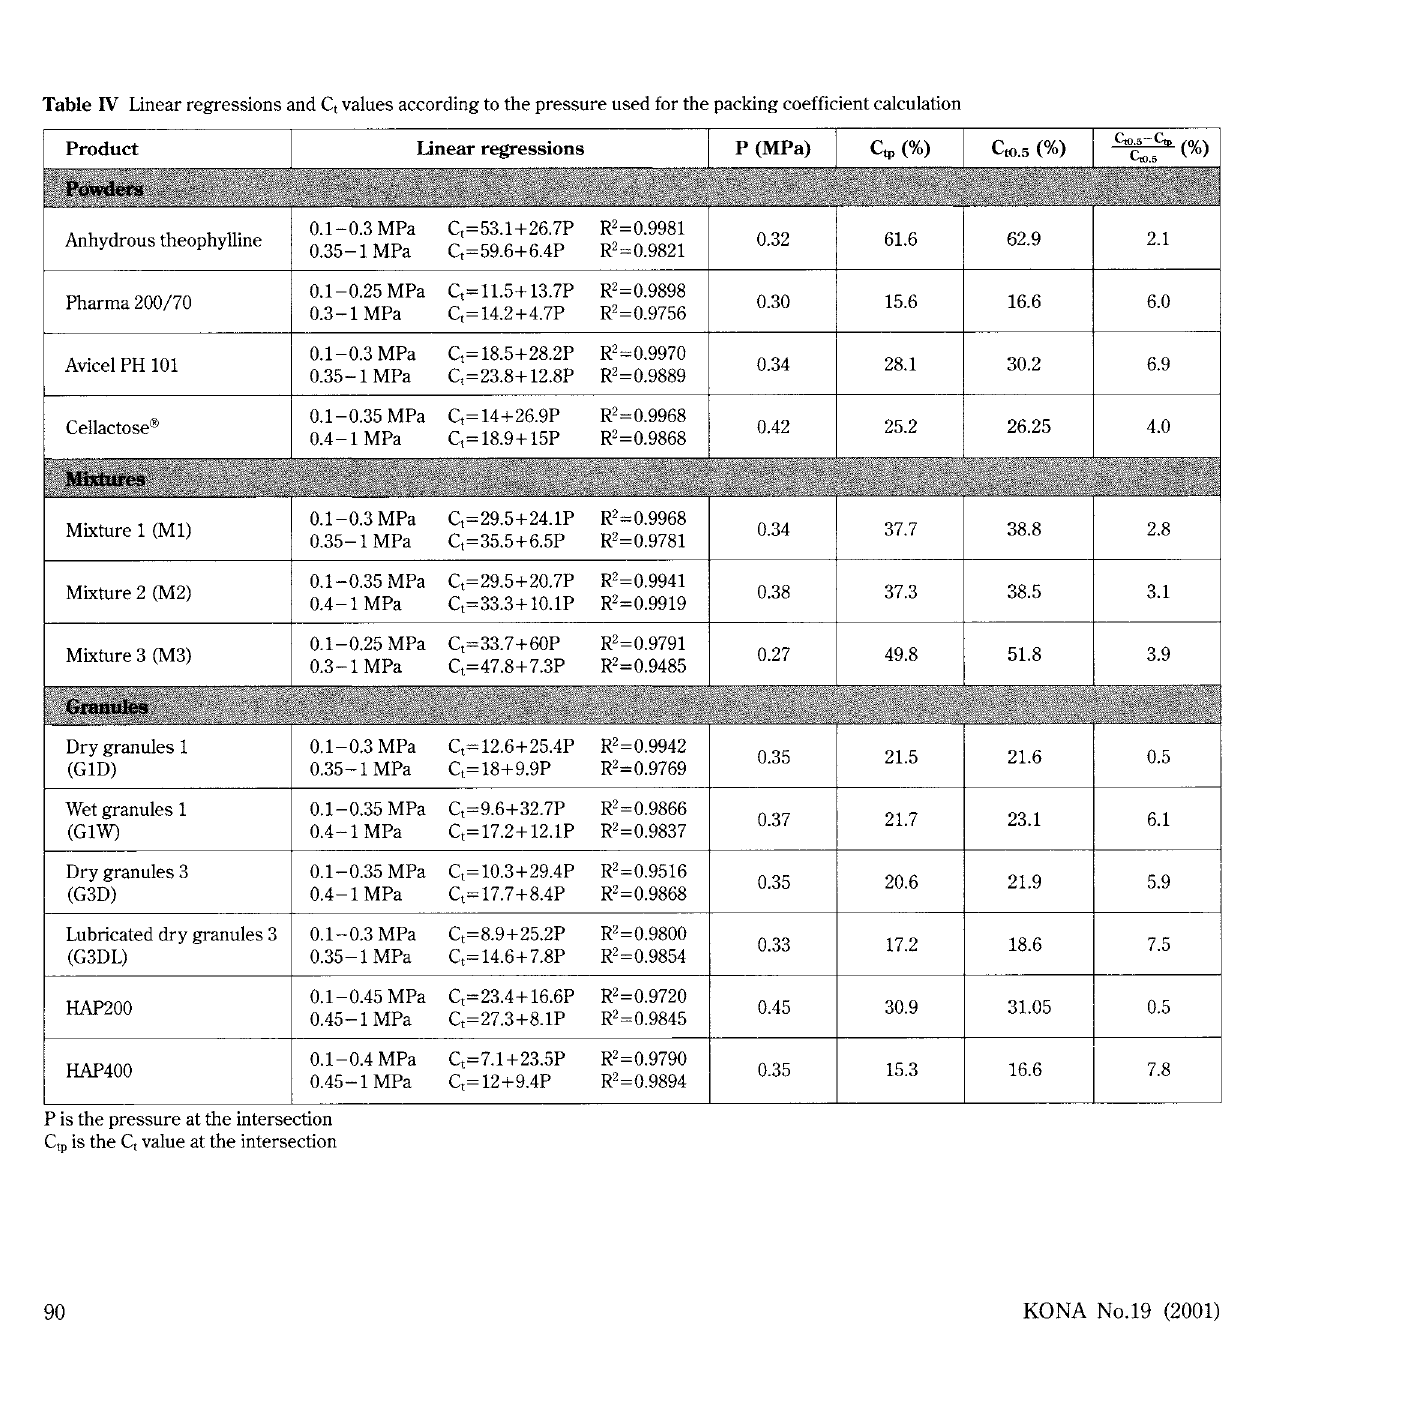
paction pressure (MPa)